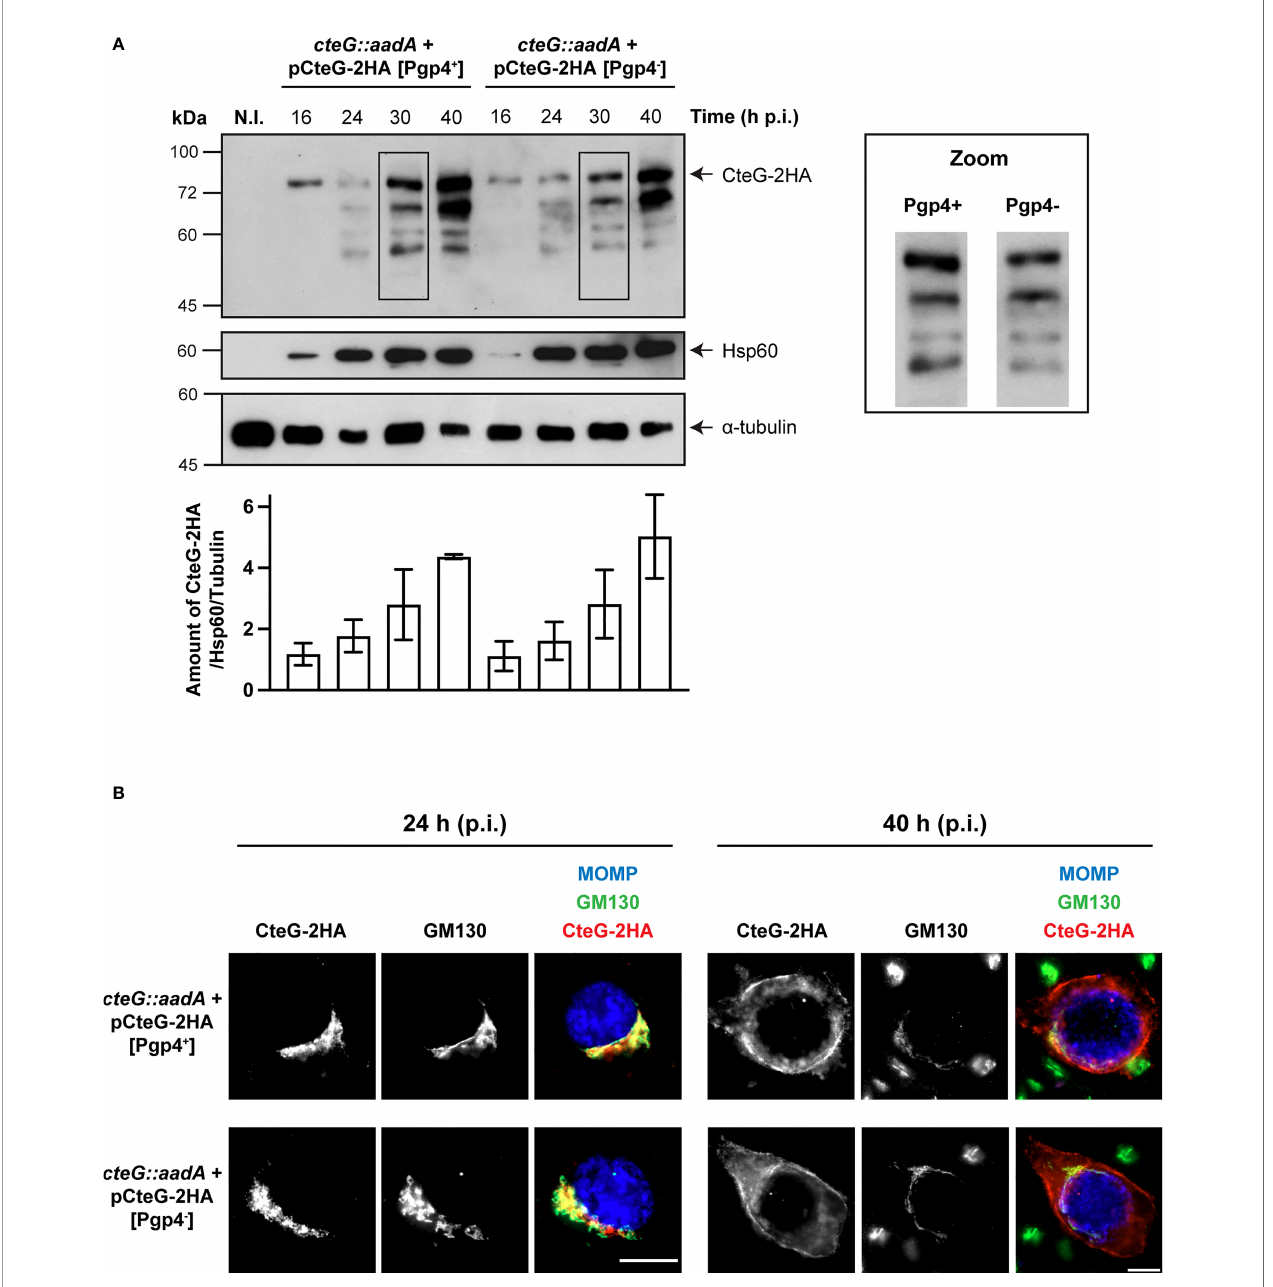
FIGURE 4 | Pgp4 does not modulate the production or the localization of CteG during C. trachomatis infection. HeLa cells were either left non-infected (N.I.) or infected with C. trachomatis cteG::aadA strains carrying pCteG-2HA[Pgp4 + ] (also named pCteG-2HA in Table 1 and in Figures 1 – 3 ; Pgp4 + /CteG-2HA + ) or pCteG-2HA[Pgp4 - ] (Pgp4 - /CteG-2HA + ) (A) At 16, 24, 30 or 40 h post-infection (p.i.), whole cell extracts were prepared and then analyzed by immunoblotting with antibodies against HA (CteG-2HA), C. trachomatis Hsp60 (bacterial loading control) and human a -tubulin (HeLa cell loading control), and using SuperSignal West Pico detection kit (Thermo Fisher Scienti fi c) to detect Hsp60 or a -tubulin, or SuperSignal West Femto detection kit (Thermo Fisher Scienti fi c) to detect CteG-2HA. The band corresponding to full-length CteG-2HA is indicated with an arrow. Zooms of the band pattern of CteG-2HA species at 30 h p.i. in both pgp4 + and pgp4 - backgrounds are displayed. The intensity of all bands on each lane was quanti fi ed using the software Fiji and summed to obtain the intensity of all CteG-2HA species at a given time point. Each value was normalized to the bacterial and HeLa cell loading controls. Bars correspond to mean ± standard error of the mean (n=3). (B) Cells were fi xed with PFA 4% (w/v) at 24 or 40 h p.i. and immunolabelled with antibodies against C. trachomatis major outer membrane protein (MOMP; blue), cis -Golgi network (GM130; green) and HA (CteG-2HA; red), and appropriate fl uorophore-conjugated secondary antibodies. Scale bar, 10